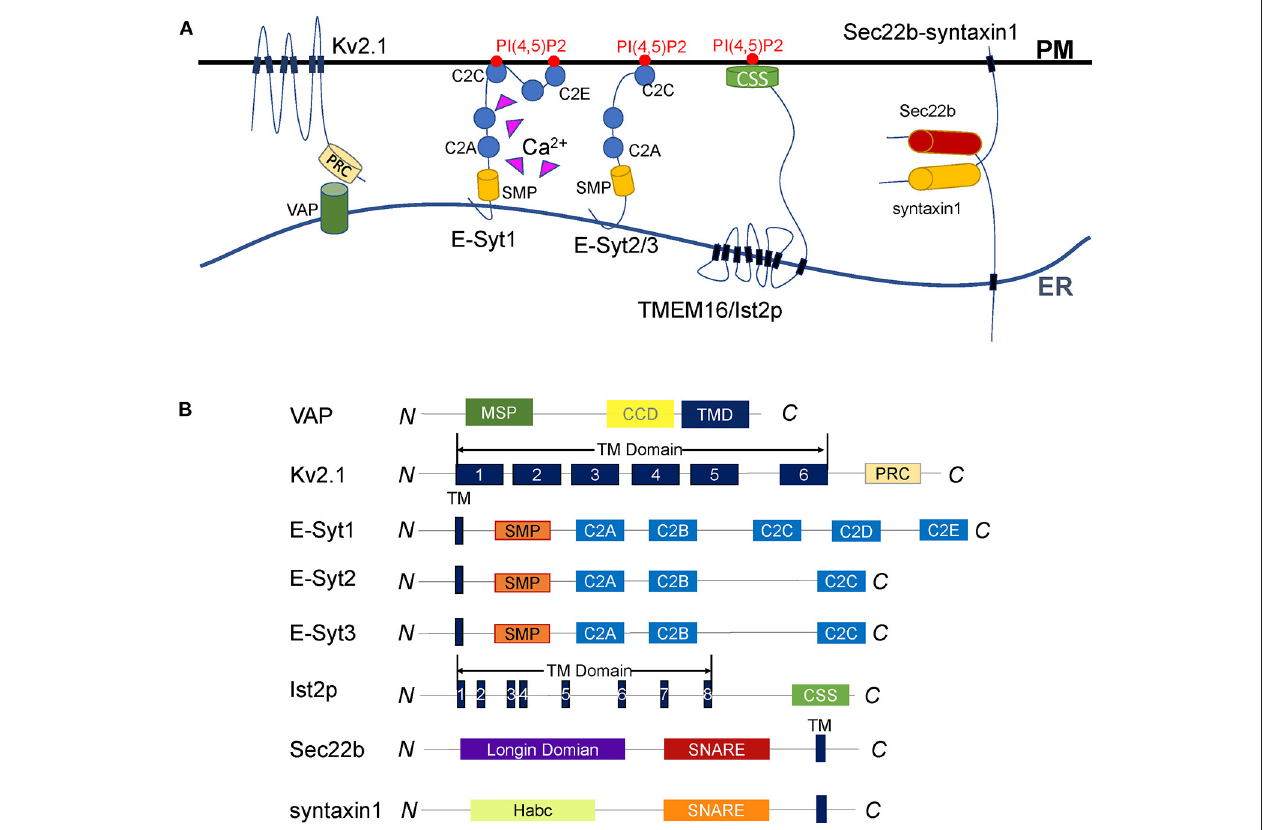
FIGURE 1 | Diverse tethering mechanisms of proteins at ER-PM contact sites. (A) Representative illustration of the proteins that tether the ER and the PM. VAP anchors to the ER surface through the transmembrane domain and interacts with its binding partners to tether the ER and PM. The Kv2.1 channel is a VAP-binding partner. It anchors to the PM by six transmembrane domains and interacts with VAP through the C-terminal PRC domain. The Kv2.1-VAP interaction bridges the ER-PM junctions regulated by PRC domain phosphorylation. E-Syts are ER membrane proteins anchored to the ER via an N-terminal hydrophobic hairpin. E-Syt1 dynamically tethers the ER to the PM through a Ca 2 + -dependent interaction between the C2C domain and PI(4,5)P2. E-Syt2/3 constitutively maintains ER-PM junctions regardless of Ca 2 + . TMEM16/Ist2p is an eight-span integrin protein in the ER and connects the ER to the PM by its C-terminal CSS domain binding to PI(4,5)P2. The ER SNARE protein Sec22b forms an incomplete trans-SNARE complex with syntaxin1 on the PM that does not mediate membrane fusion but promotes the ER and PM tethering. (B) Diagrams of the membrane tethering proteins described in (A). The major functional domains are shown in each of the proteins.